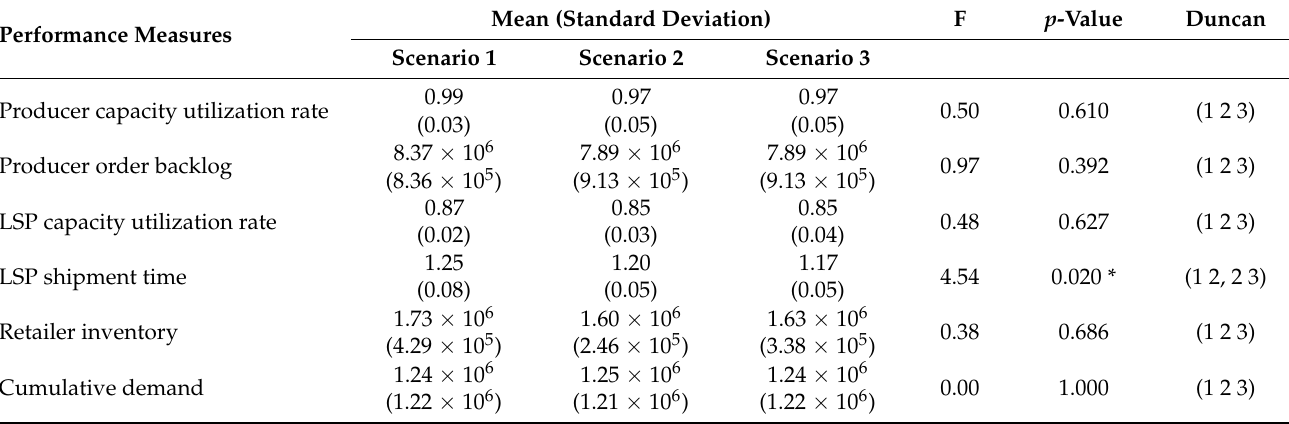
Table 5. The MANOVA results for an LSP capacity disruption.